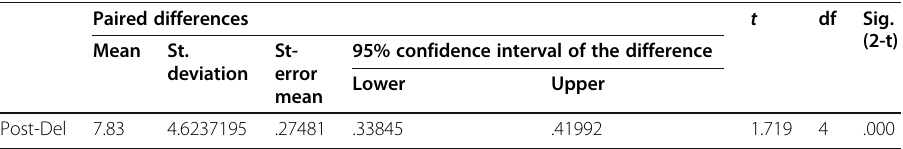
Table 8 Pair-sampled T -test for the post-test and delayed post-test Paired